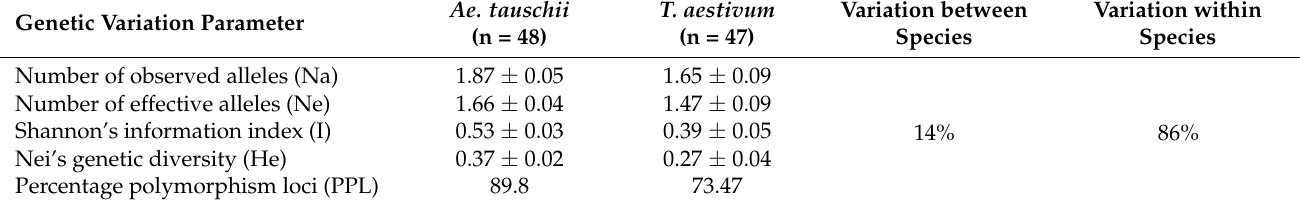
Table 4. Summary of estimated genetic variation indices in two Ae. tauschii and T. aestivum species. Genetic Variation Parameter